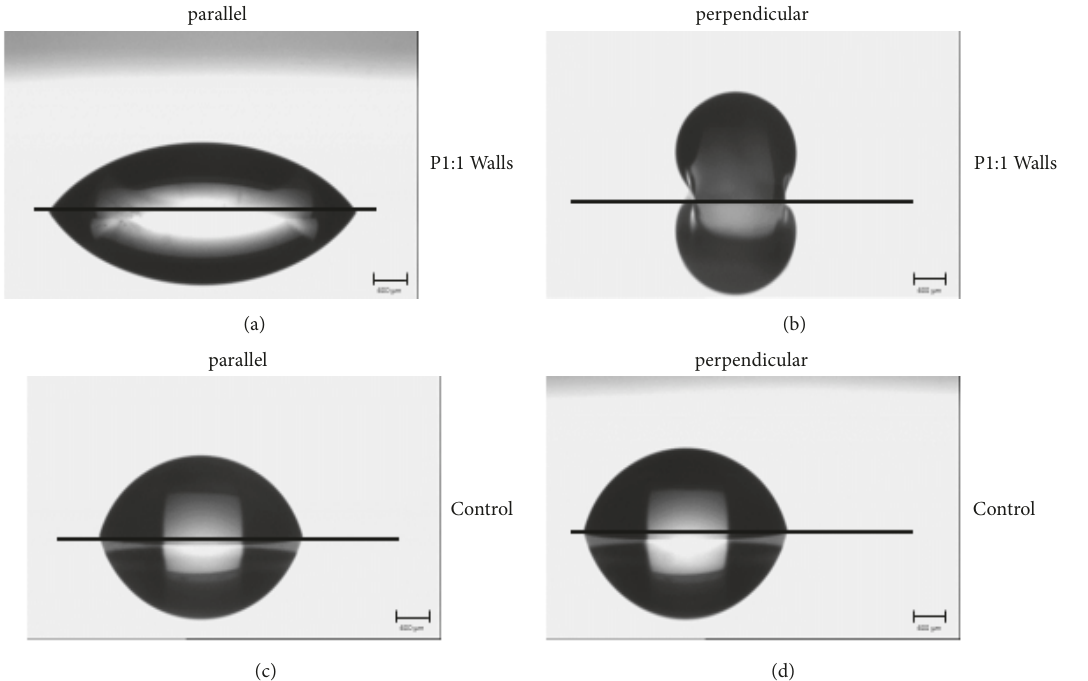
Figure 3: Energy optimized model of water droplets. Behaviour of water droplets on nonstructured control and P1:1 walls. (a) Water droplet parallel to P1:1 walls; (b) water droplet perpendicular to P1:1 walls; (c) water droplet on nonstructured control, parallel; (d) water droplet on nonstructured control,